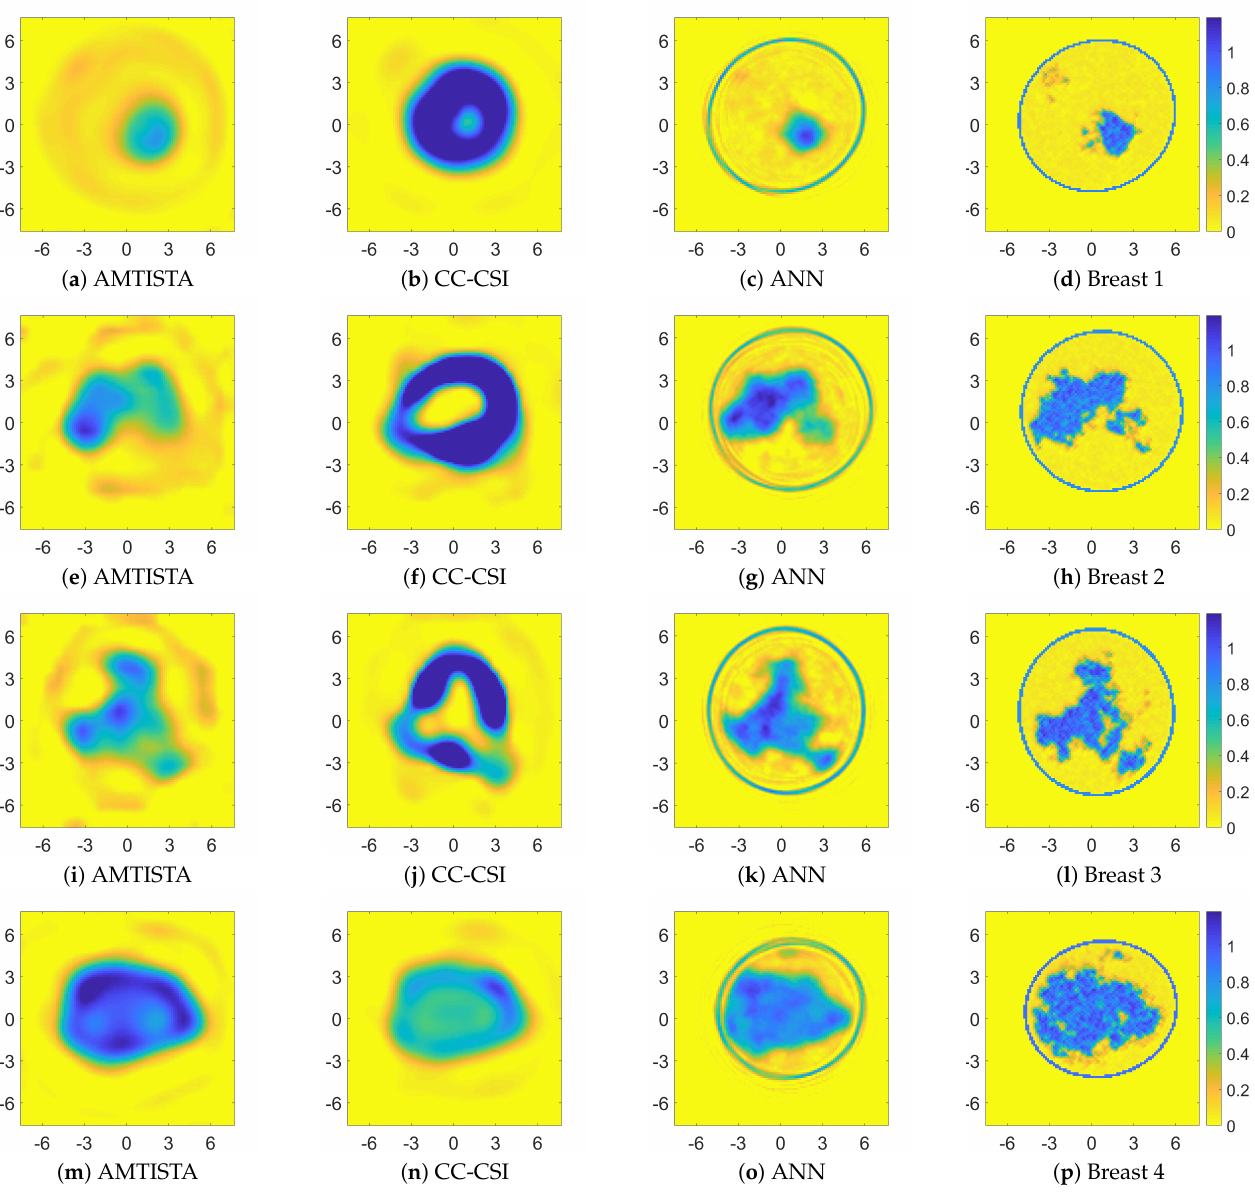
Figure 7. Comparison between recoveries related to four different breast profiles (one per each class). Retrieved conductivity maps (measure unit: S/m) for AMTISTA (DBIM formulation as reported in [70]) ( a , e , i , m ), cross-correlated CSI (CC-CSI) [87] ( b , f , j , n ), and proposed ANN approach ( c , g , k , o ). Reference conductivity maps are reported in ( d , h , l , p ). Both the x and y axes are in centimeter